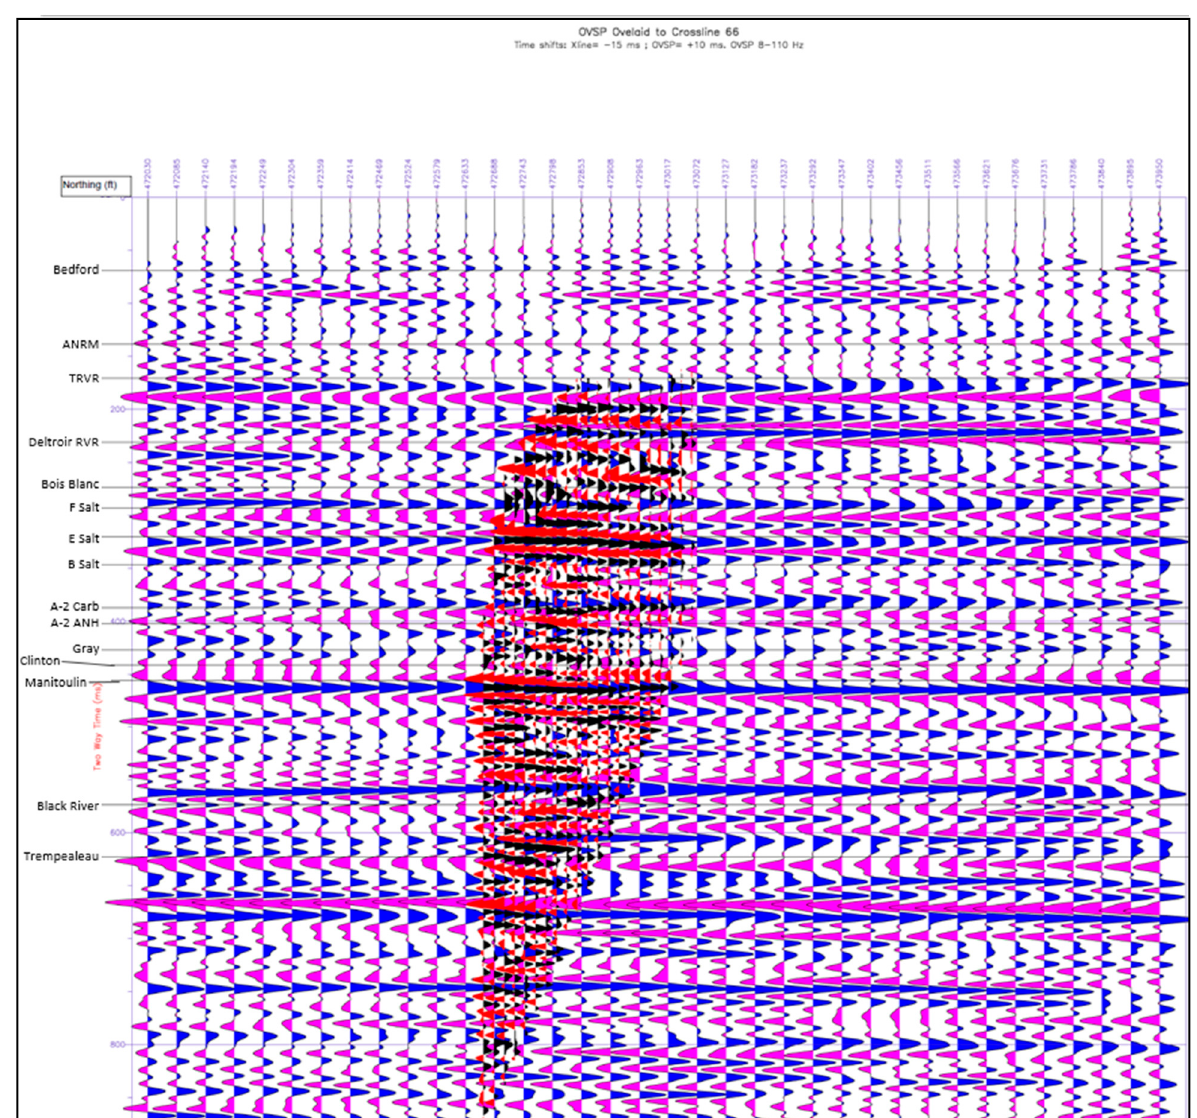
Figure 3. Acquired and processed VSP results overlain onto crossline 66 (north-south directions) of the Puttygut seismic volume.